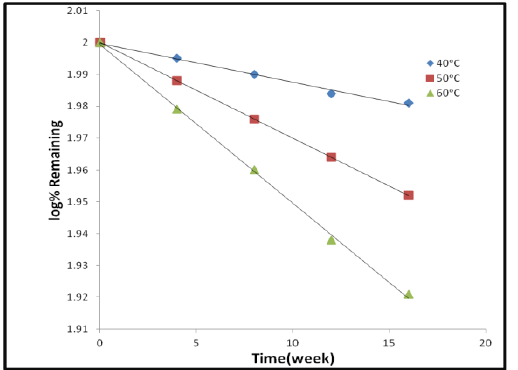
Figure9: First order plot for the degradation of aspirin in bilayer tablet at different temperature